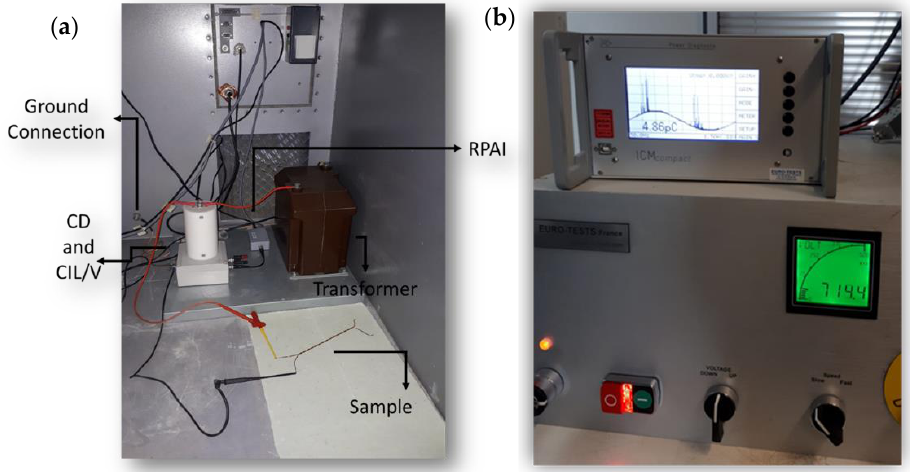
Figure 6. PDIV device. ( a ) Faraday cage. ( b ) ICM compact with the voltage control box.